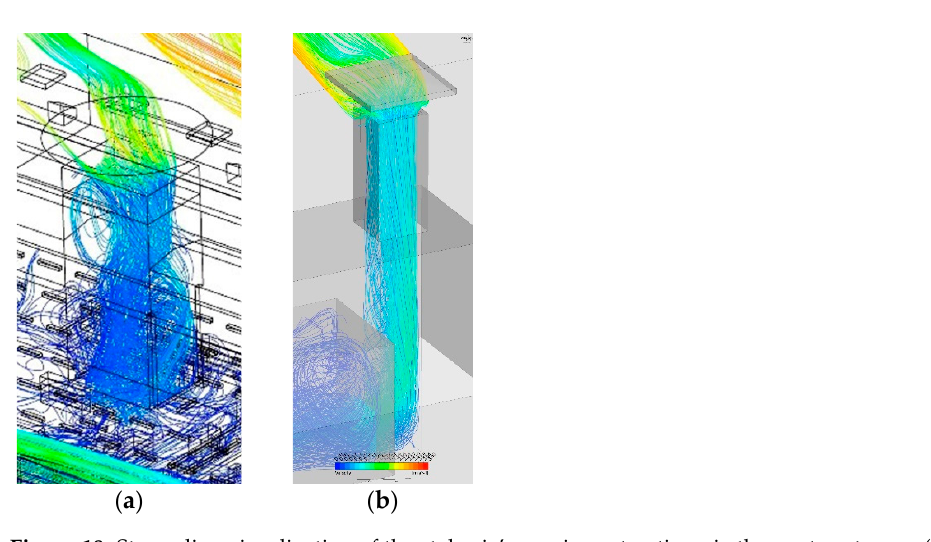
Figure 18. Streamline visualization of the stale air’s passive extraction via the venture tower: ( a ) The authors’ former study showed the possible energy loss inside an oversized wind tower via vortices [34]. ( b ) The proposed geometry ratios in this studies avoided the unintentional energy loss, and the stale air has a straight upward movement.